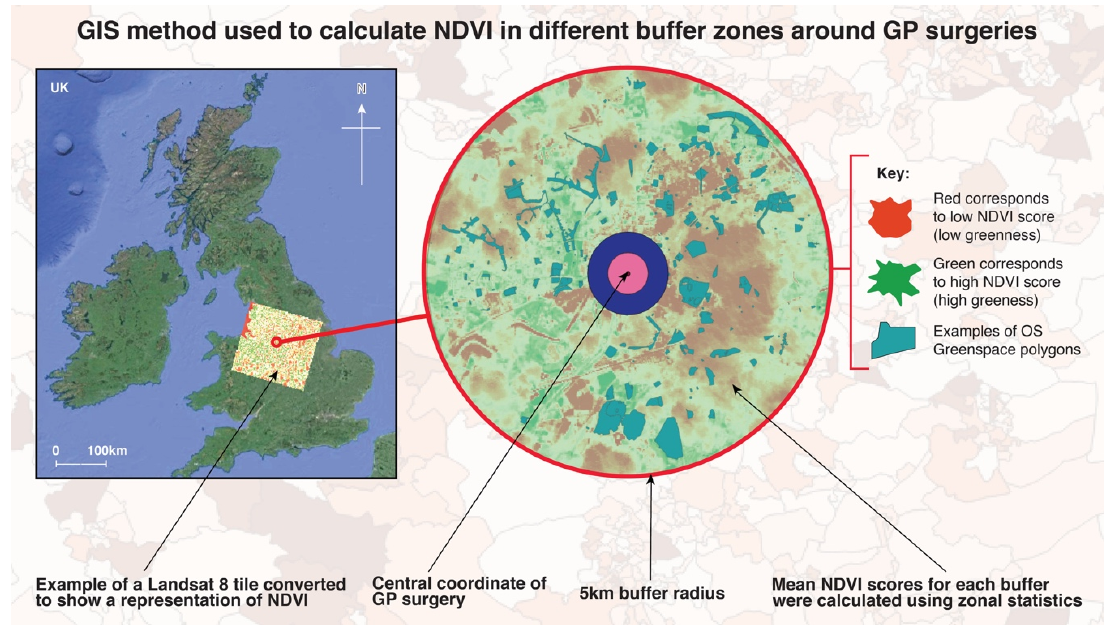
Figure 4. Example of buffer zones around GP surgeries with a visual representation of the Normalised Difference Vegetation Index (NDVI). The mean values within these buffers was calculated and exported for further analysis. The whole of the UK was overlaid with the NASA Landsat 8 tiles to facilitate NDVI calculations.